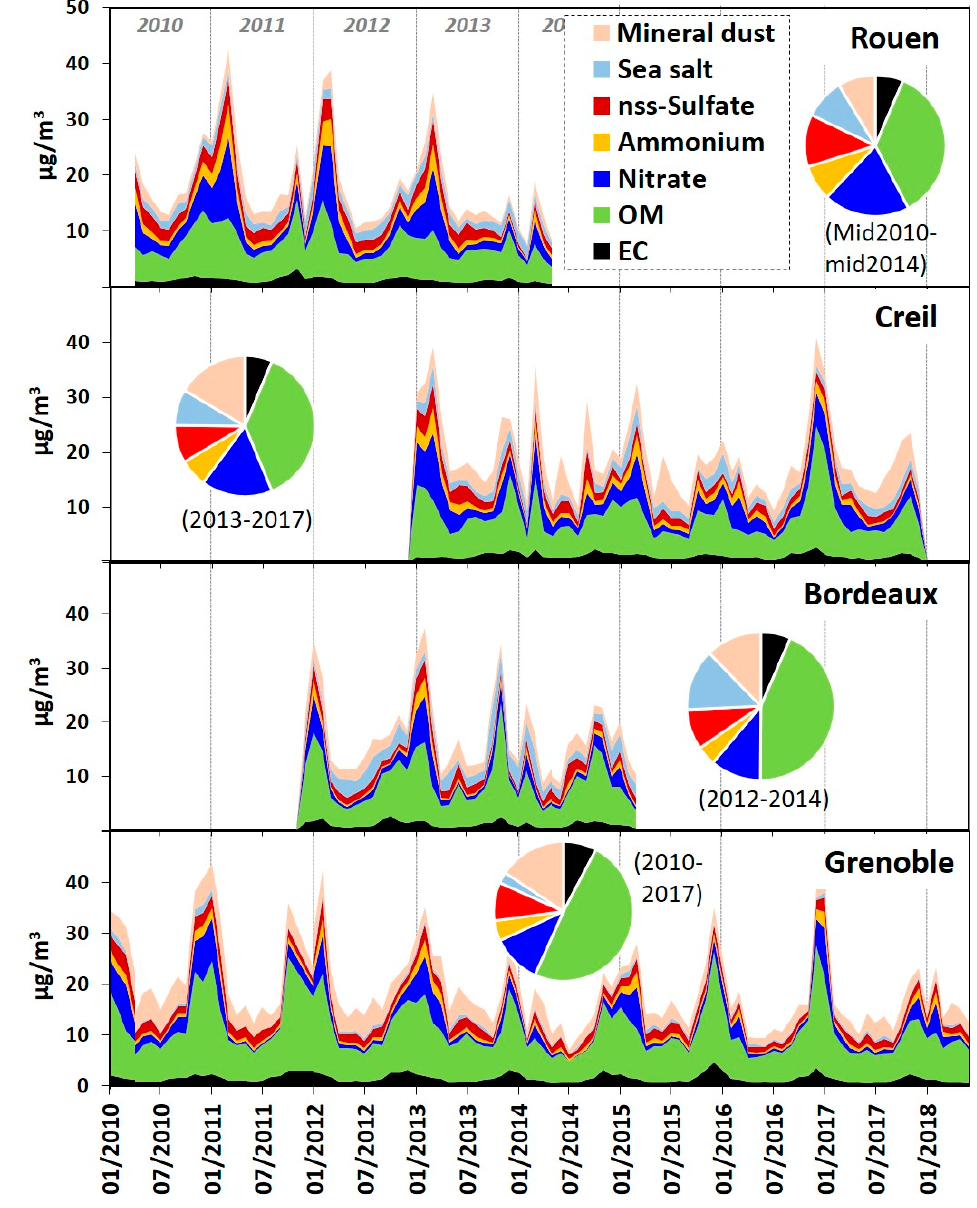
Figure 5. Multi-year variations of main PM 10 components (monthly-mean values) as measured at 4 sites of the CARA program over the period 2010–2018.